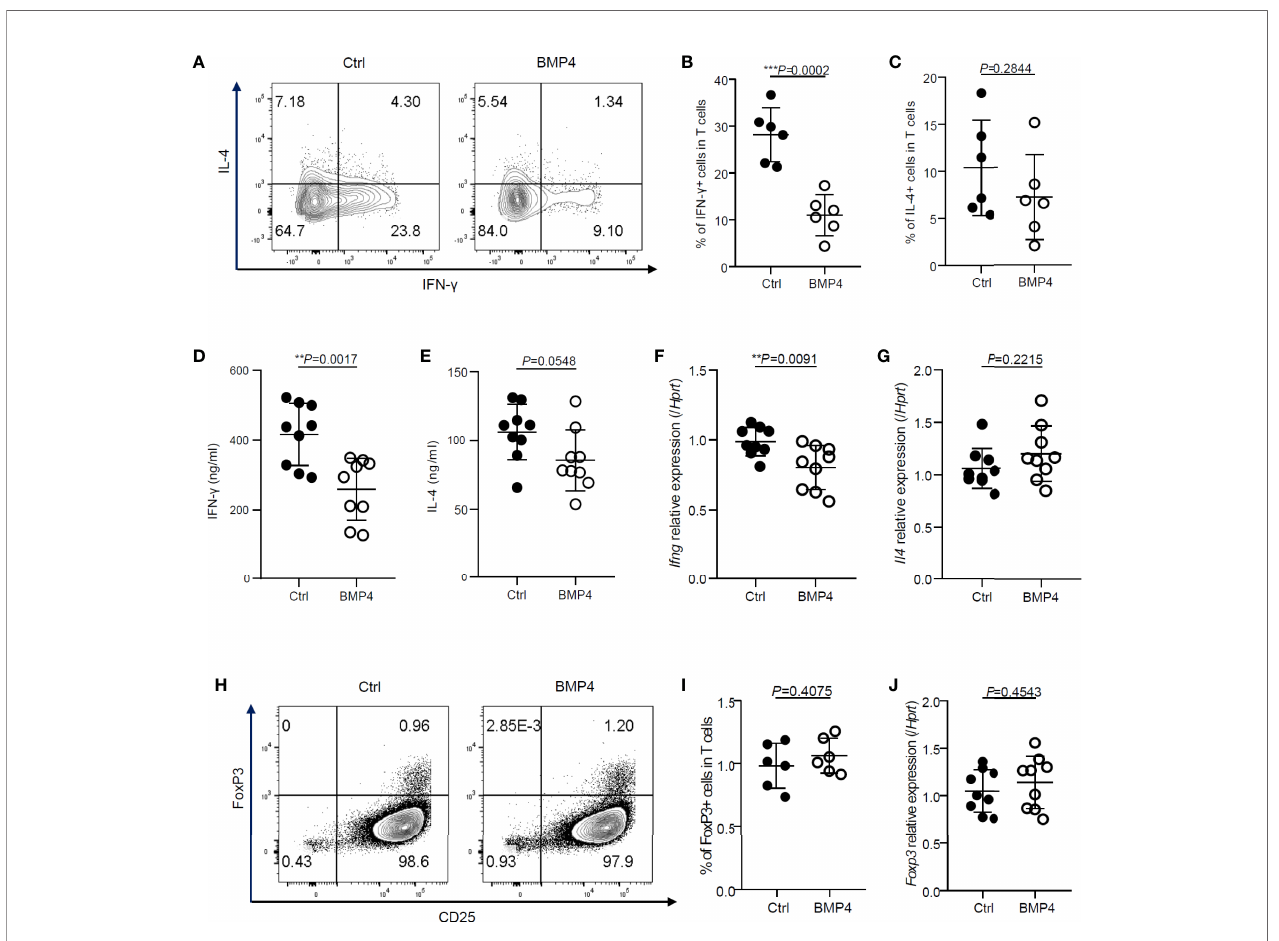
FIGURE 2 | BMP4 downregulates the IFN- g production of CD4+ T cells without increasing Tregs. (A) The expression of IFN- g and IL-4 on T cells were tested by fl ow cytometer 3 days after TCR activation with or without BMP4 treatment. (B) The frequency of IFN- g + T cells. (C) The frequency of IL-4+ T cells. (D) The concentration of IFN- g + in the supernatant of T cells culture medium 3 days after TCR activation with or without BMP4 treatment. (E) The concentration of IFN- g + in the supernatant of T cells culture medium. (F) The gene expression of Ifng checked by Quantitative real-time PCR. (G) The gene expression of Il4 . (H) The expression of FoxP3 on T cells tested by fl ow cytometer. (I) The frequency of FoxP3+ T cells. (J) The gene expression of